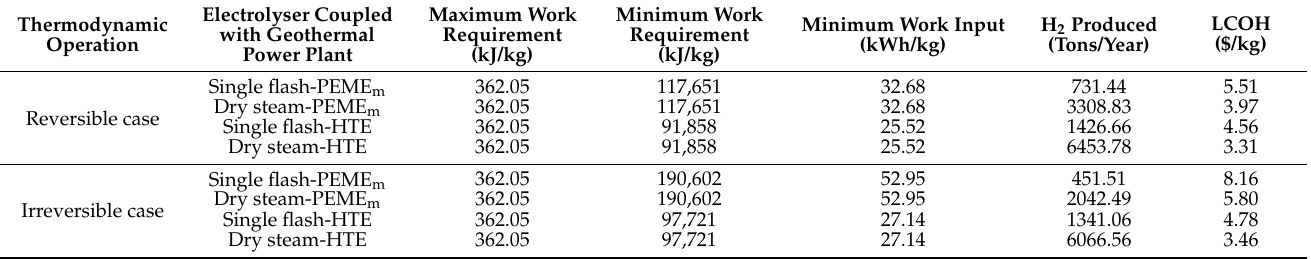
Table 5. Result of green hydrogen production supply with the geothermal energy